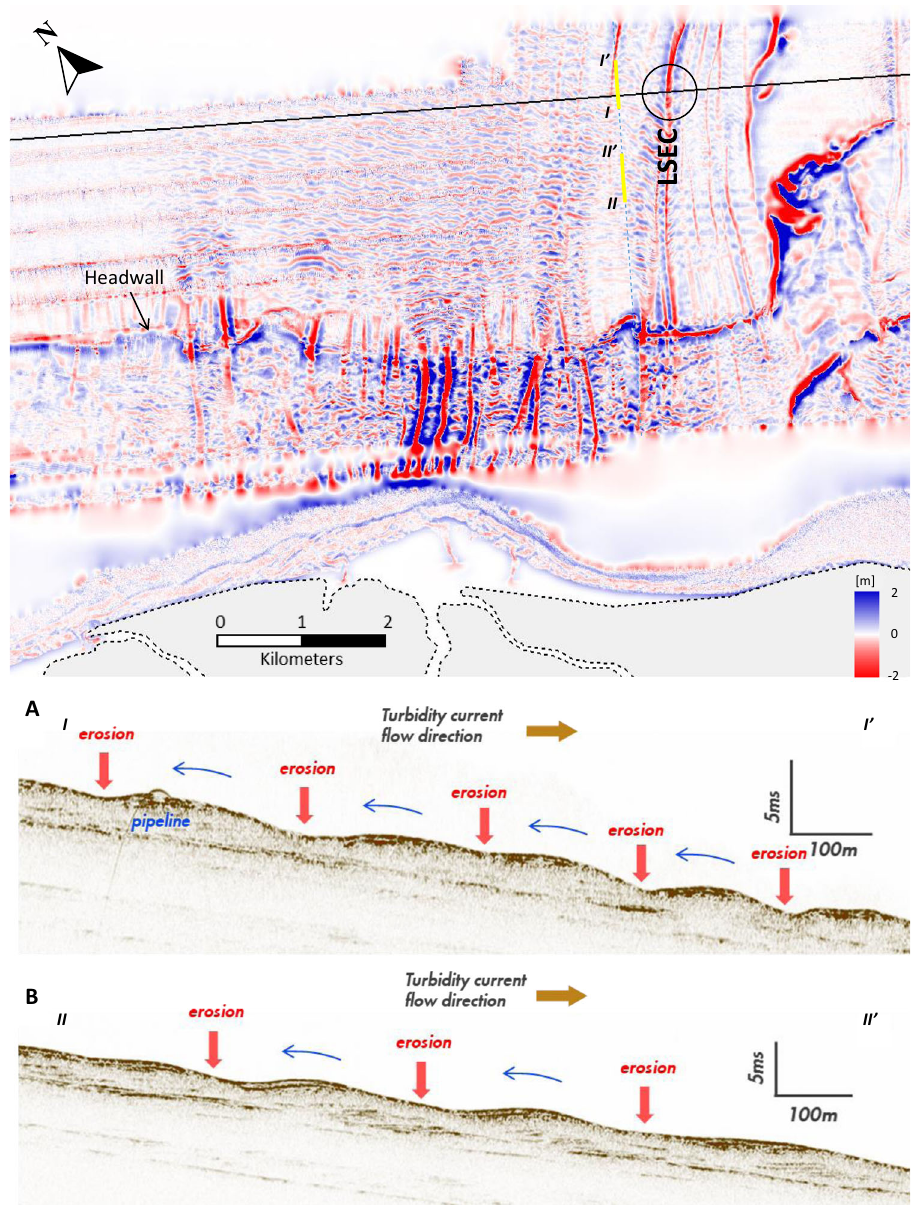
Fig. 2 Map of the bedforms observed in the slope off the MT delta. Bedforms presence, location and orientation are highlighted by subtracting from the high-resolution bathymetry map a smoothed low-pass fi ltered version of it. The black continuous line marks pipeline path. Black circle indicates the location of pipeline displacement. Insets a and b represent two downslope segments of sub-bottom pro fi le data revealing the internal stratigraphy and the upstream migration of the